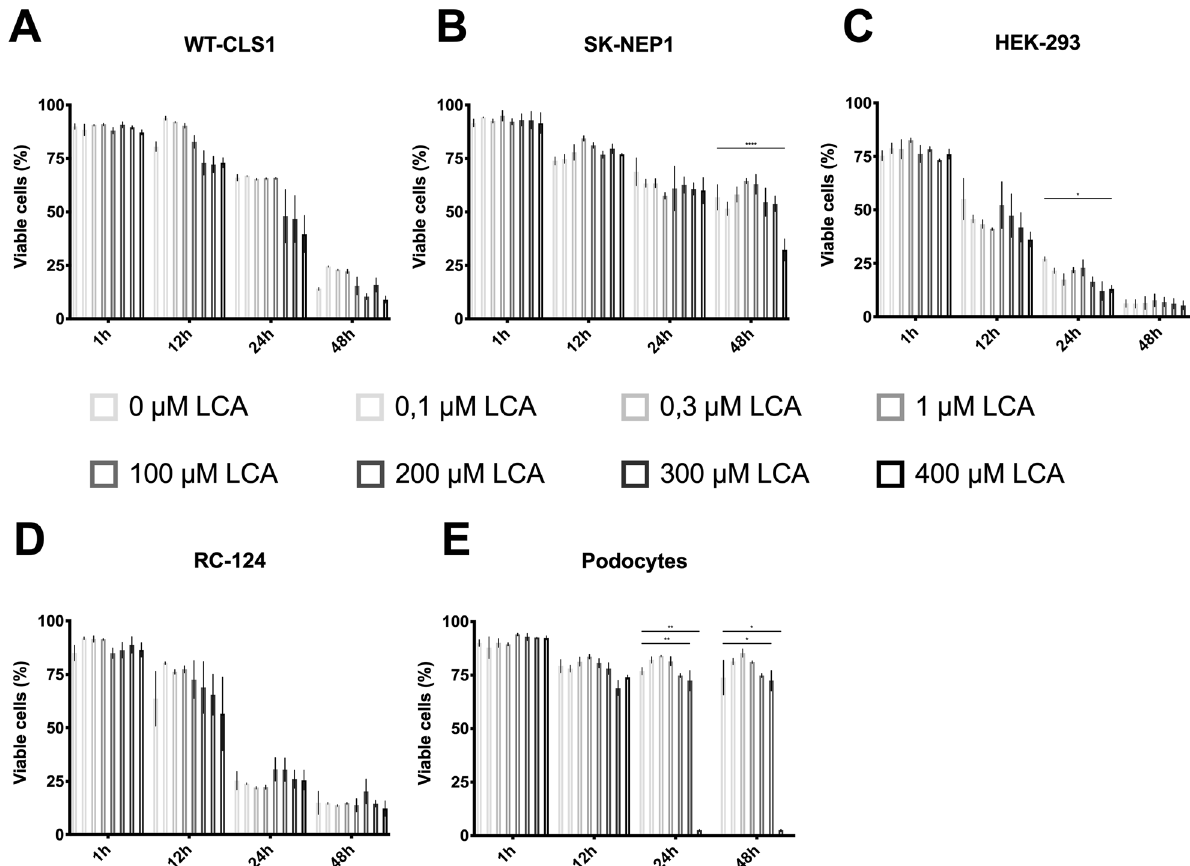
Figure 3. Podocytes versus nephroblastoma cell line under LCA treatment. All cell-lines were treated as described in “Methods”. Cells were stained with Annexin V and PI. Viable cells were defined as Annexin V and PI negative. Data were evaluated using FlowJo and Prism and are presented as mean ± SD of values from three independent experiments. Significance level was set as p < 0.05 (*< 0.05; **< 0.005; ***< 0.0005; ****<